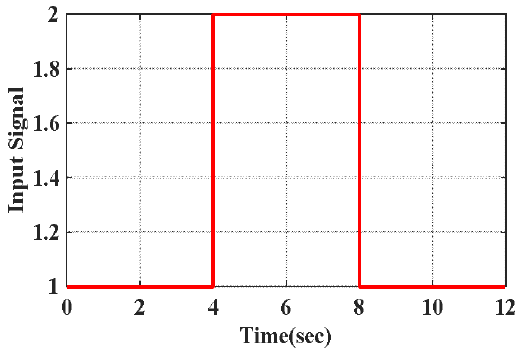
Fig. 12. Multi-step input of mag.2.